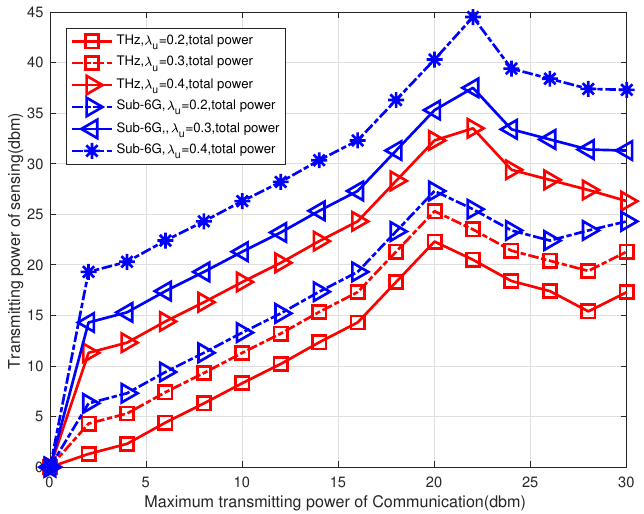
Figure 7. Relationship between sensing and communication powers.